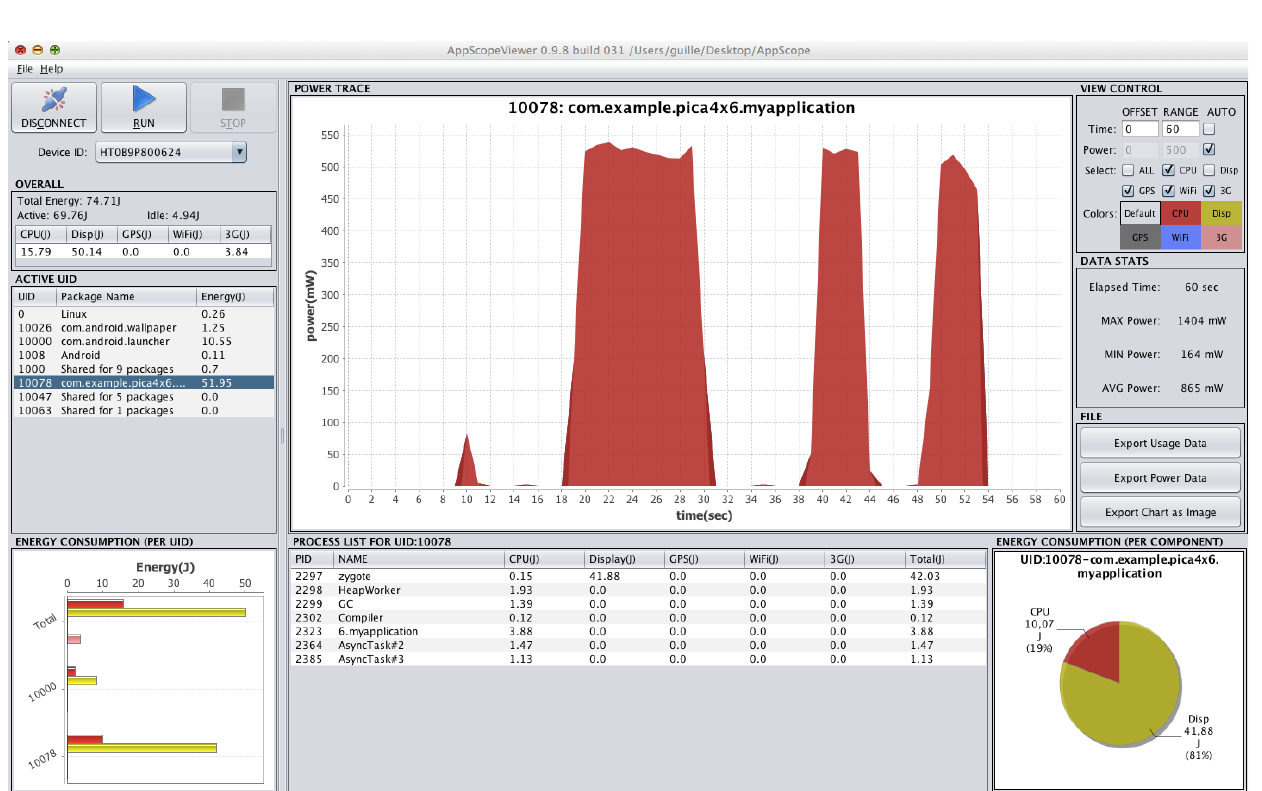
Figure 6. Power consumption trace of the CP-ABE Setup () , KeyGen () , Encrypt () and Decrypt () methods in an Android